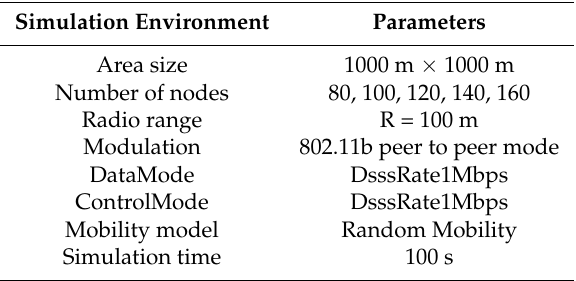
Table 1. Simulations’ parameters.